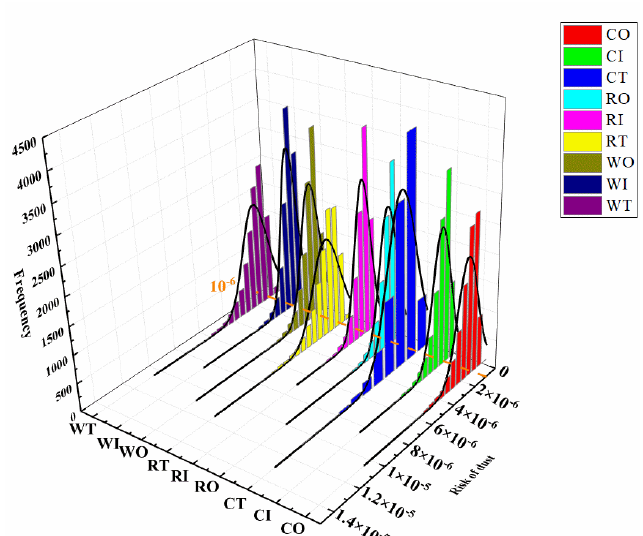
Figure 4. Distribution of health risk values in different storage stages for each grain. Remarks: CO refers to the out-warehousing stage of maize; CI refers to the in-warehousing stage of maize; CT refers to the transporting stage of maize; RO refers to the out-warehousing stage of rice; RI refers to the in-warehousing stage of maize; RT refers to the transporting stage of maize; WO refers to the out-warehousing stage of maize; WI refers to the in-warehousing stage of maize; and WT refers to the transporting stage of maize. The rest of the paper is the